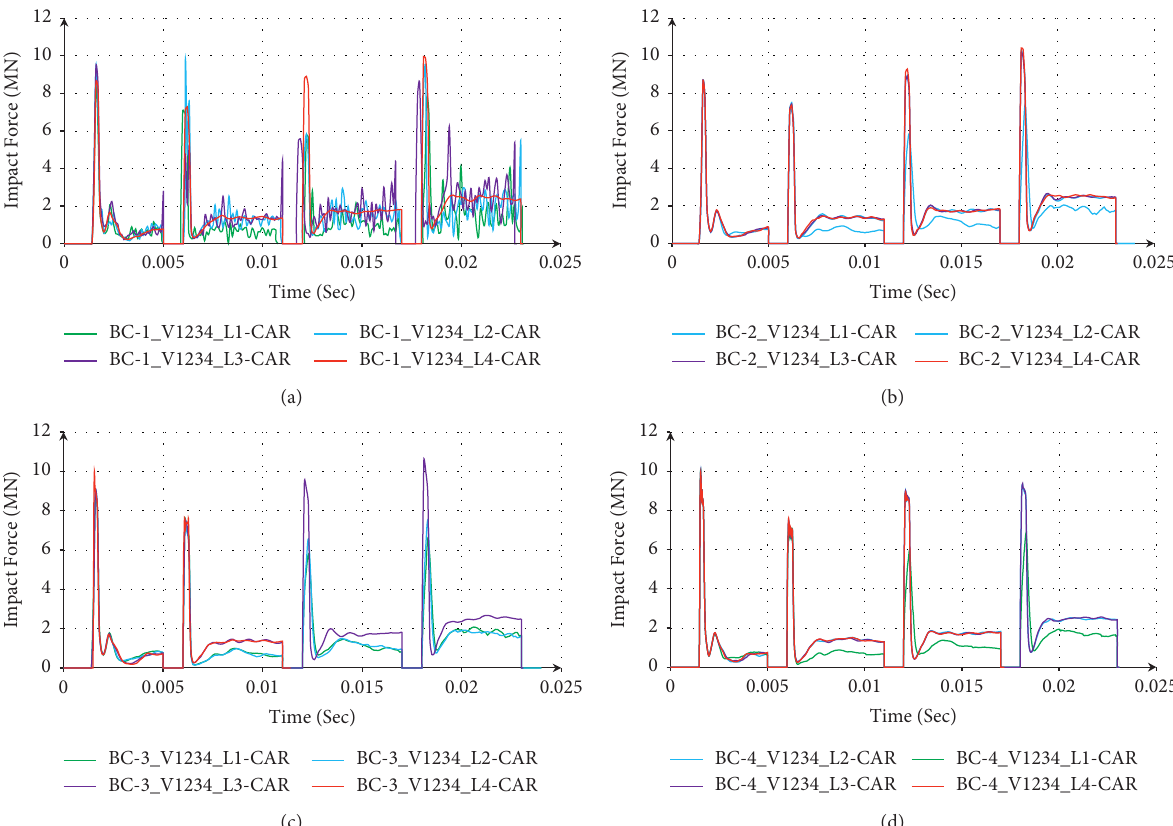
Figure 16: Effect of axial load on repetitively impacted BRC columns. (a) Normal reinforcement distribution without bundling (BC-1). (b) Two-bundle reinforcement distribution (BC-2). (c) Three-bundle reinforcement distribution (BC-3). (d) Four-bundle reinforcement distribution